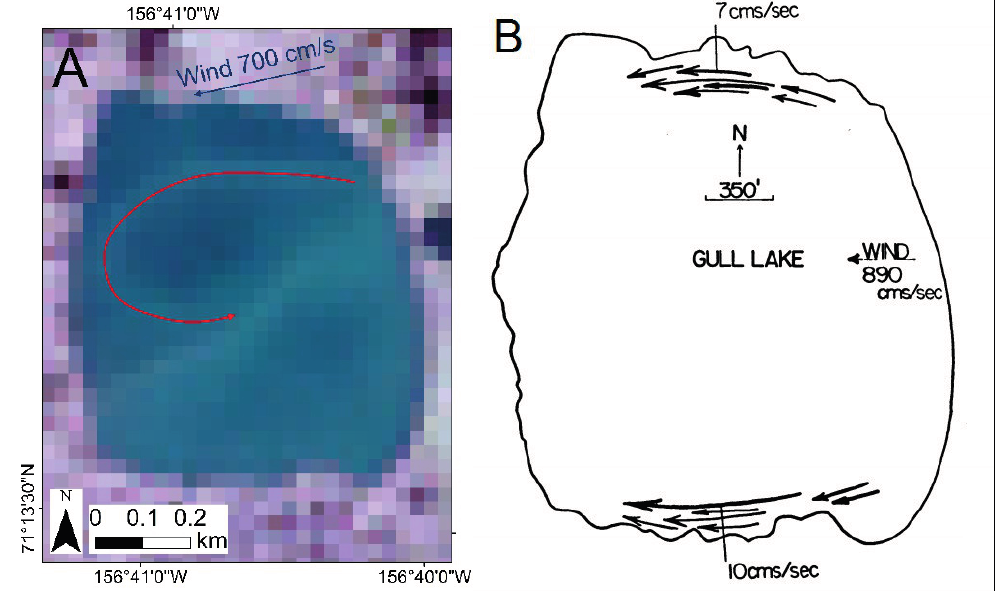
Figure 14. Comparison of gyre patterns observed by Landsat 8 in Gull Lake near Barrow, Alaska on 10 July 2013 ( A ) with flow patterns determined by dye and float experiments by Carson and Hussey [12] ( B ) (Figure B adapted from Carson and Hussey [12] with permission from The Chicago University